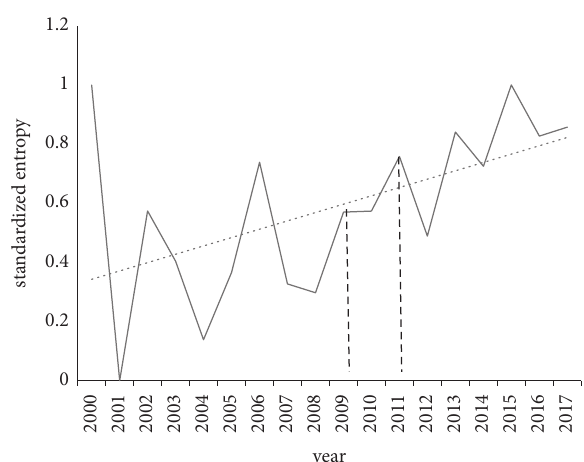
Figure 6: Evolution stages of the nonferrous metal collaborative innovation